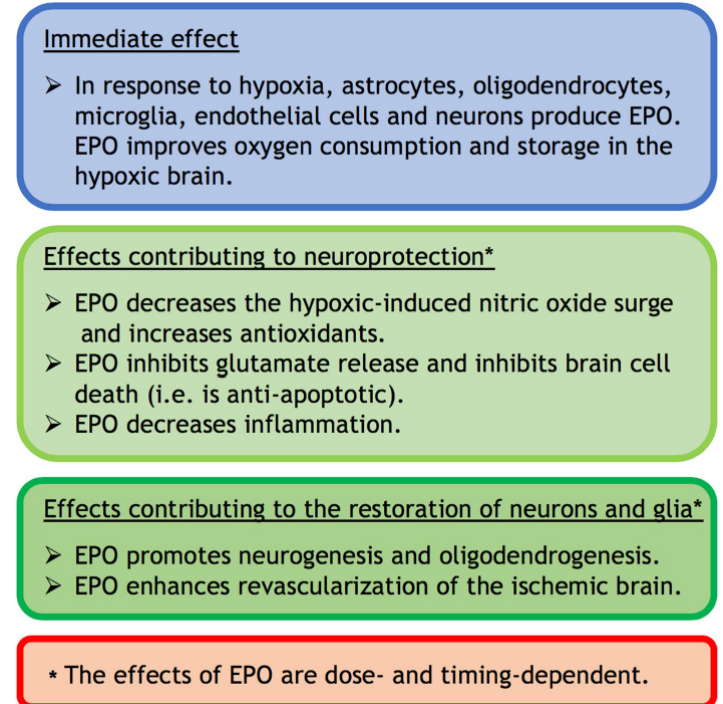
Figure 2. A summary of the immediate, neuroprotective, and restorative effects of EPO in the hypoxic-injured brain.